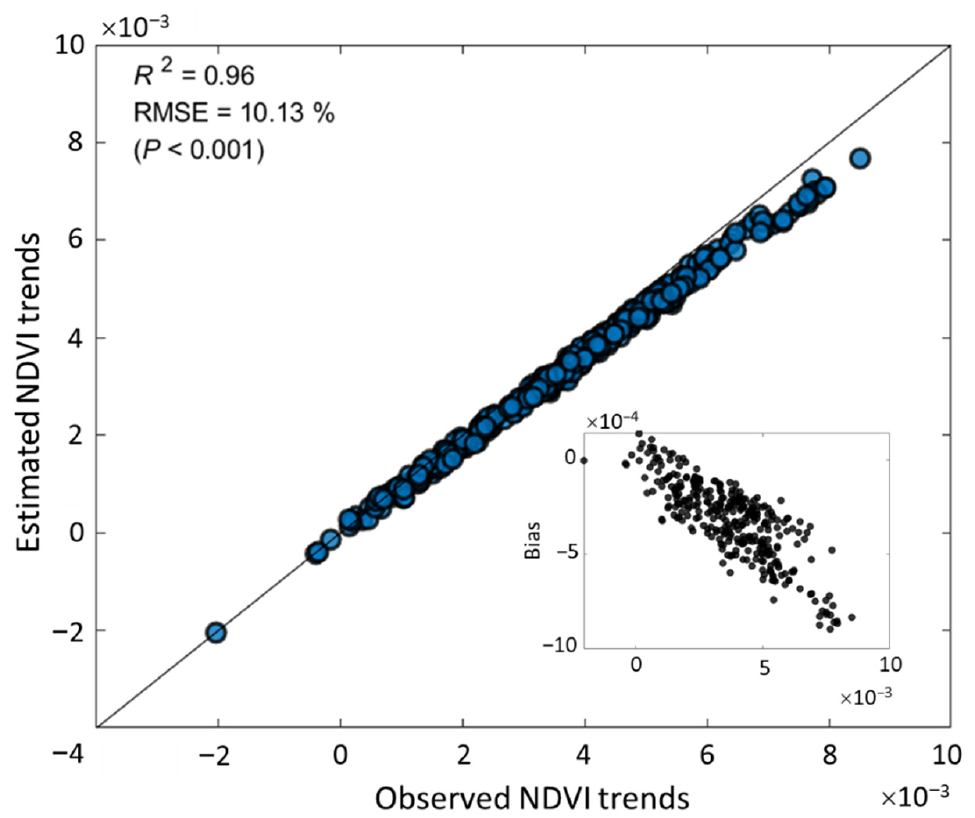
Figure 5. Relationship between observed and estimated slopes of annual normalized difference vegetation index (NDVI) in 334 counties. Inset: changes in bias against observed NDVI trends.